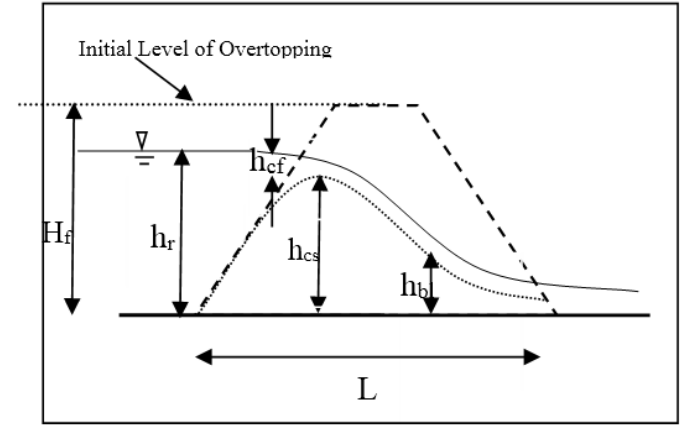
Figure 5. Di ff erent fl ow parameters. Figure 5. Different flow